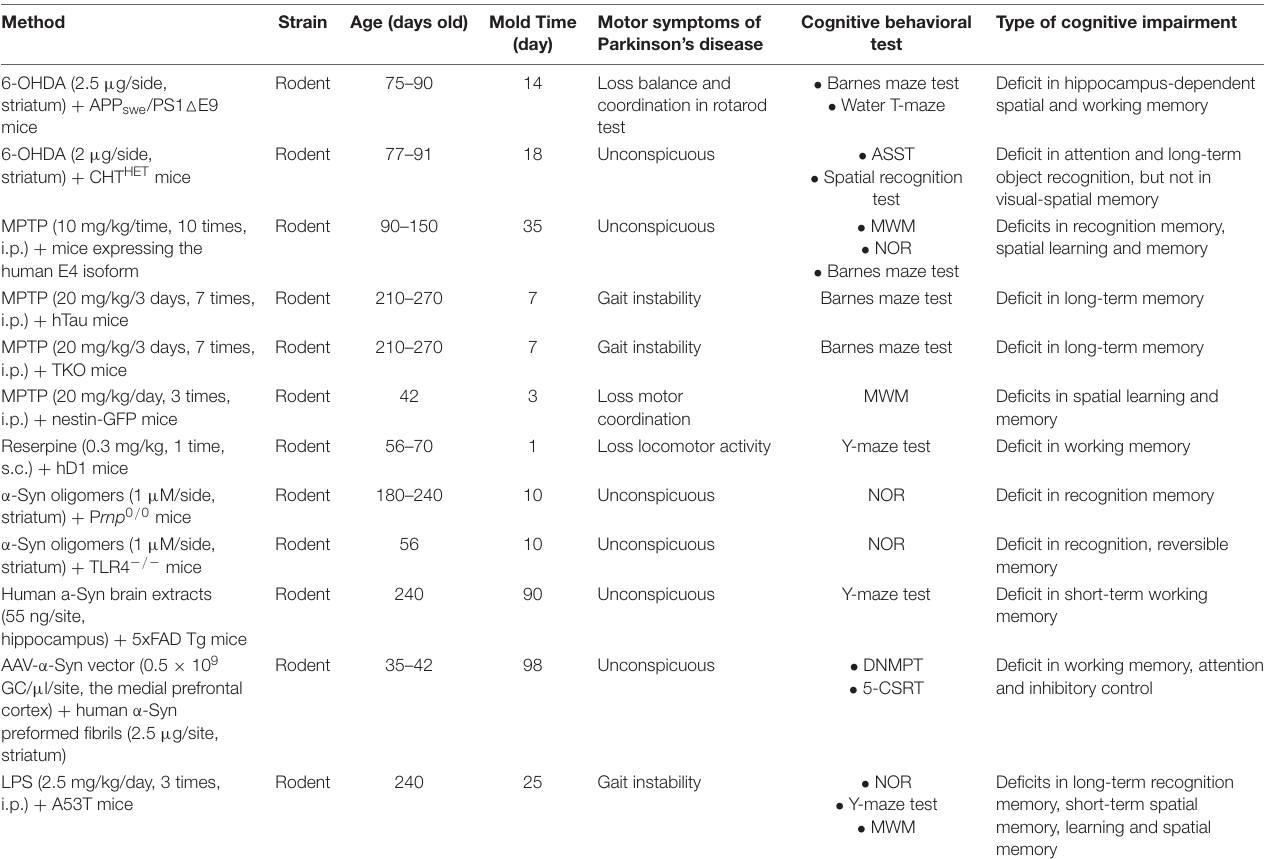
TABLE 7 | Methods of models combining toxin and transgenes.